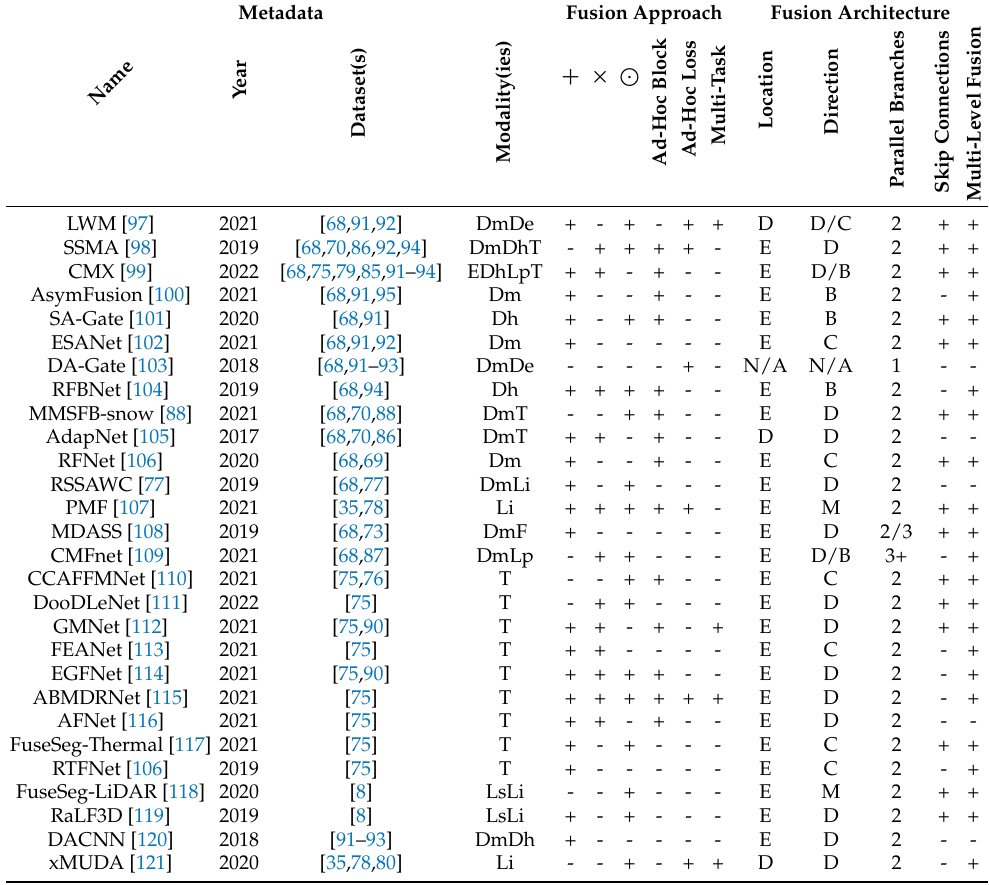
Table 3. Summary of recent multimodal semantic segmentation architectures. Modality shorthand: Dm, raw depth map; Dh, depth HHA; De, depth estimated internally; E, event camera; T, thermal; Lp, light polarization; Li, LiDAR; Ls, LiDAR spherical; F, optical flow. Location: D, decoder; E, encoder. Direction: D, decoder; C, color; B, bi-directional; M, other